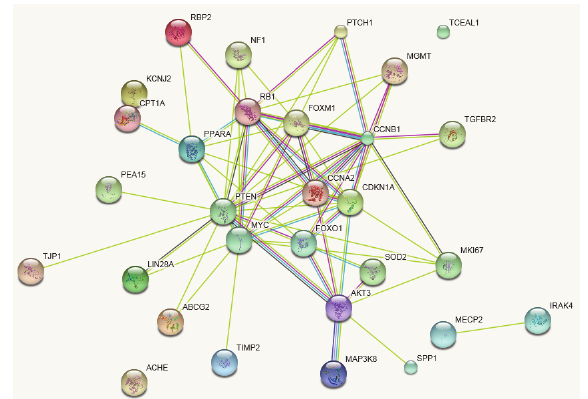
Figure 2: Metabolic pathways predicted to change by our miRNAs after LAGB. Network identified by STRING showing a close inter- action among the proteins regulated by the subset of 6 miRNAs. The above 6 miRNAs also targeted the pathways of several proteins in cancer and infection diseases (data not